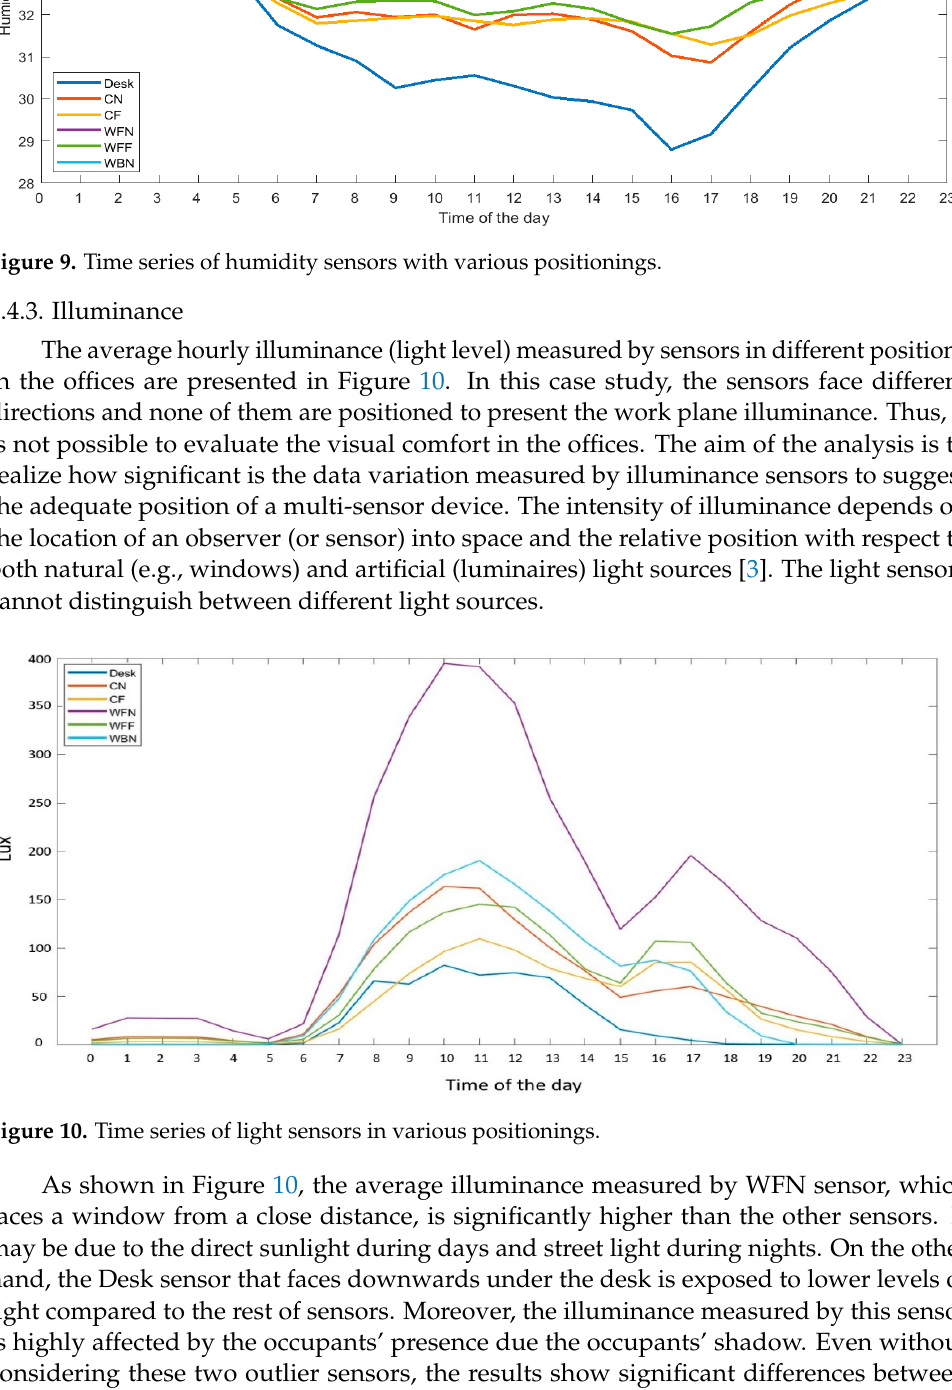
Figure 9. Time series of humidity sensors with various positionings.